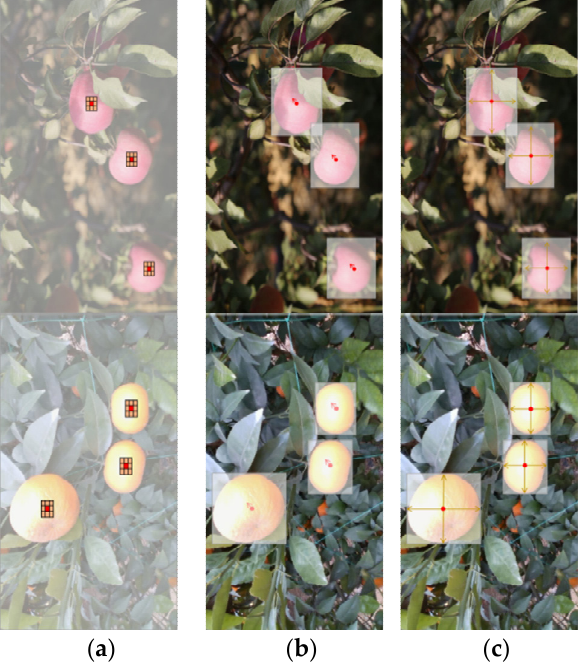
Figure 5. Example of the outputs from three branches of the CenterNet detector. ( a ) Heat map, ( b ) Local offset, ( c ) Object size.